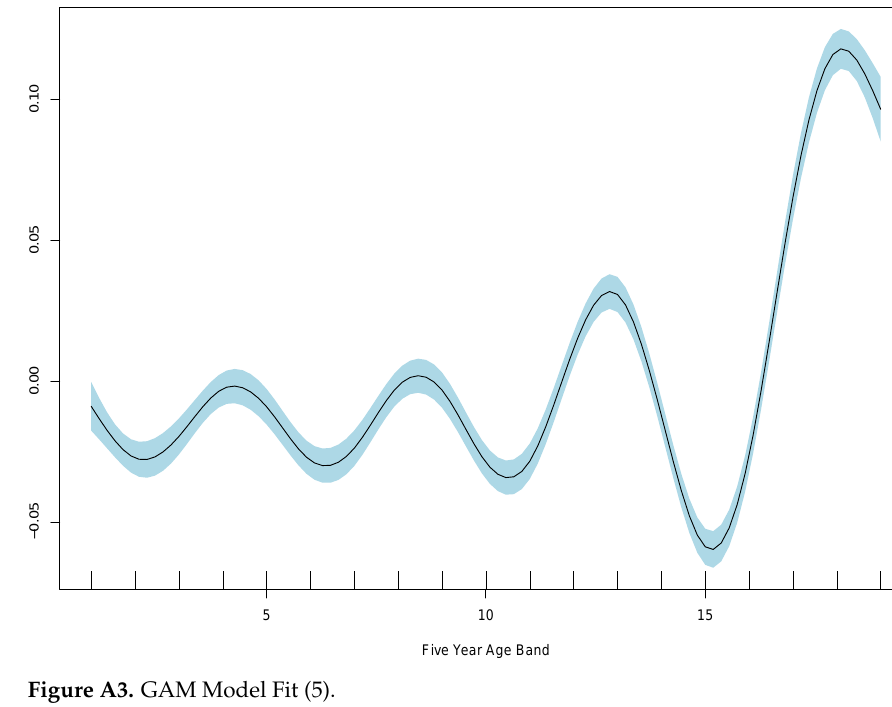
Figure A3. GAM Model Fit (5).